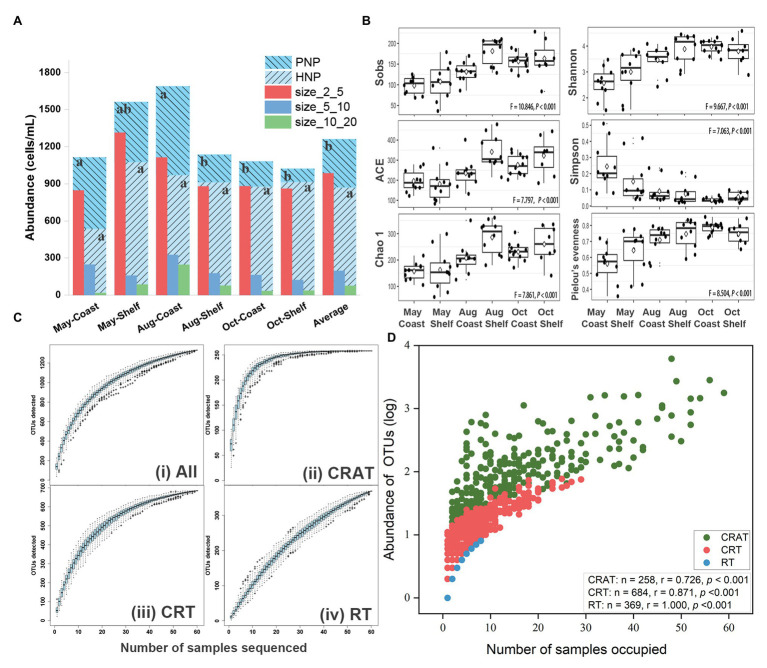
Abundance, diversity, and abundance-occupancy relationships of protist community. (A) Cell abundance, trophic structure, and size structure of nano-sized protist communities across time and space. Different letters denote significant differences among groups. (B) Boxplots displayed the temporal and spatial distribution of alpha-diversity index of protist communities. Non-parametric test (Kruskal-Wallis ANOVA) was used to compare the differences among six groups and all values of p were lower than 0.001. The hollow diamonds represent average values of individual index in each group. (C) Species accumulation curves (SAC) of protist taxa [i. all OTUs; ii. conditionally rare and abundant taxa (CRAT); iii. conditionally rare taxa (CRT); and iv. rare taxa (RT)]. Boxplots in SAC showed the range of OTU richness for each number of samples sequenced. (D) Abundance-occupancy relationships between OTU richness and number of sites occupied. Spearman’s rank correlations were used to evaluate the relationships between abundance of OTUs (log-transformed) from three different microbial subcommunities and the number of sites occupied (n is the number of OTUs).